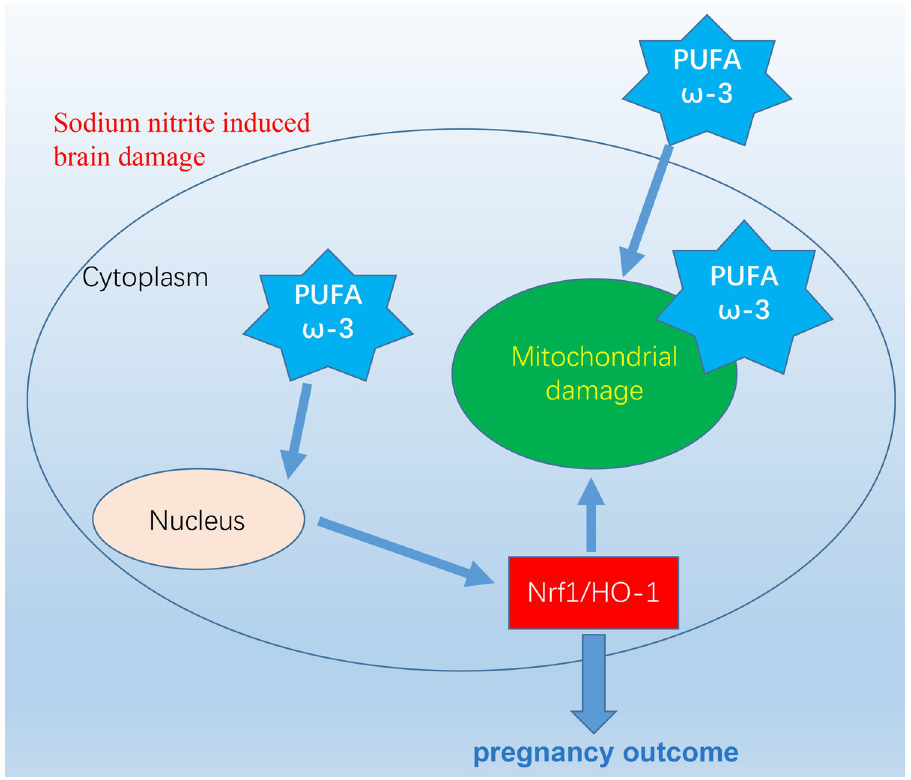
Fig 6. PUFA ω -3 may alleviate brain damage in fetal rats caused by sodium nitrite exposure during pregnancy via NRF1/HMOX1 signaling.